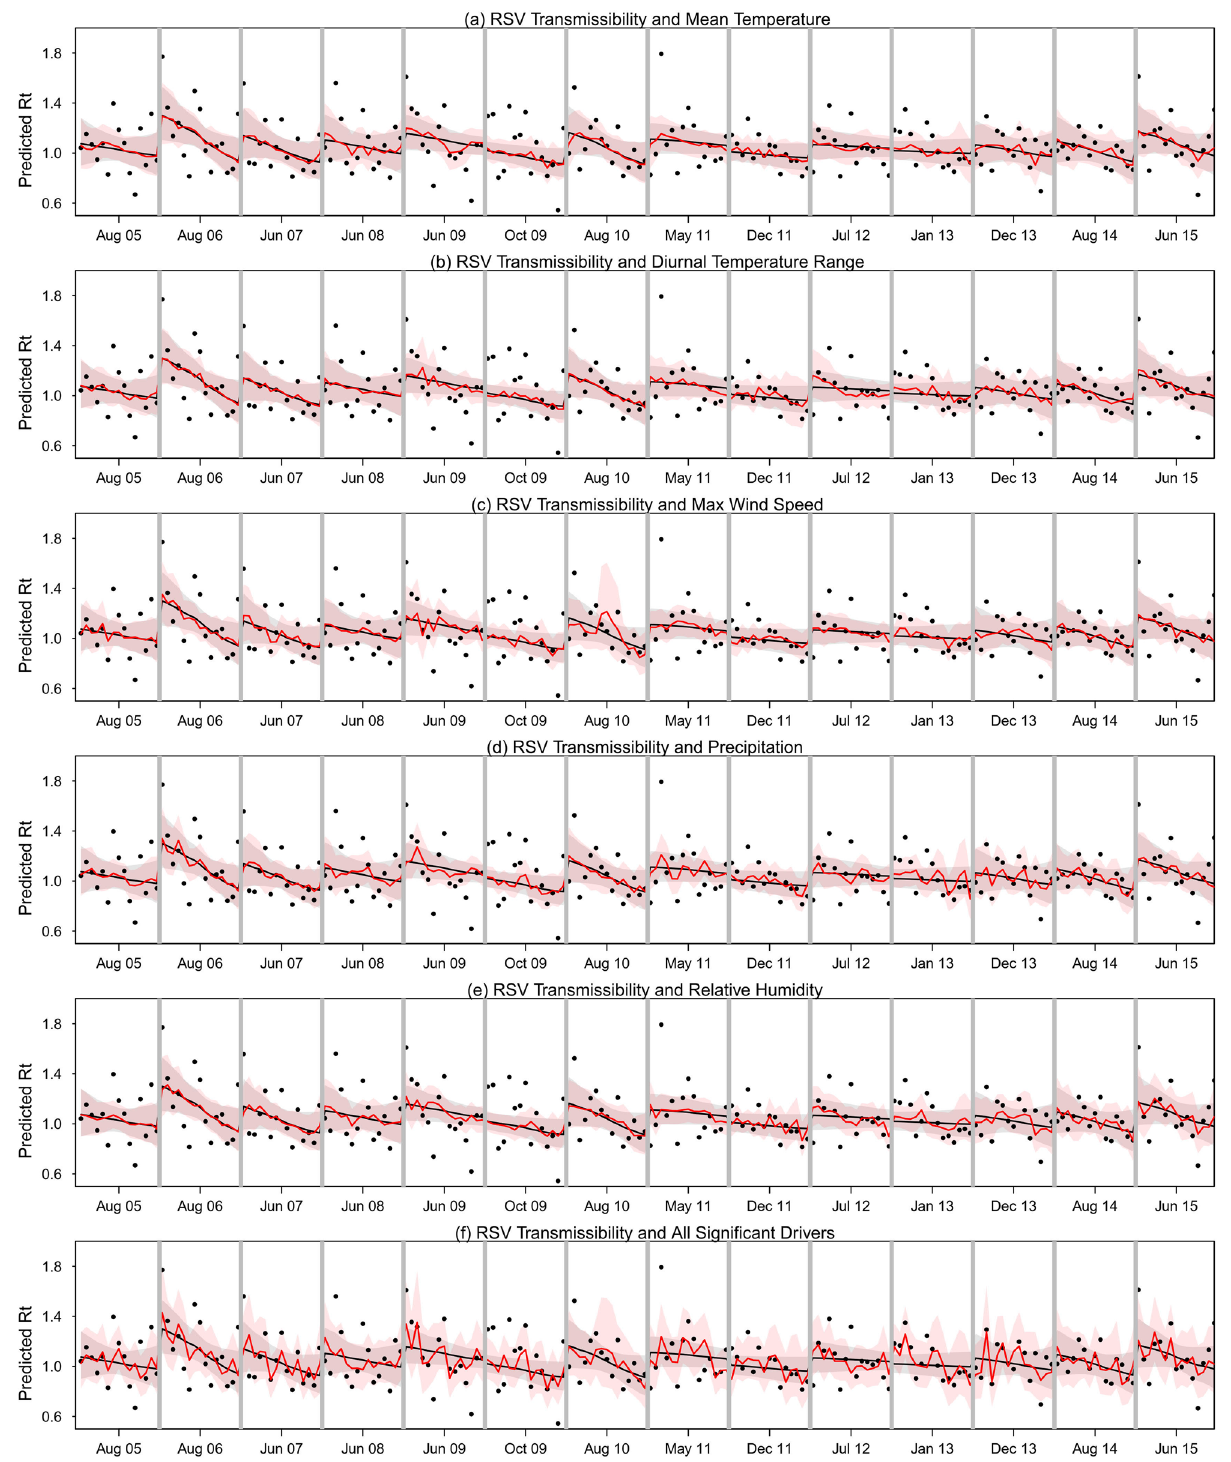
Figure 2. Effective reproduction numbers inferred from the RSV hospital admissions time series (black dots) and the predicted effective reproduction numbers from basic models with inclusion of depletion of susceptible and the inter-seasonal factors only (black lines) with 95% CI (light grey shaded area), and inclusion of meteorological drivers in addition to depletion of susceptible and the inter-seasonal factors (red lines) with 95% CI (light red shades). Total 11 epidemics (with 14 peaks) of RSV transmission in Singapore during 2005–2015. The difference between the black line and the red line illustrates the improvement in fitting due to inclusion of respective drivers. We used a maximum duration of 7 weeks to both side of peaks and a 5-days moving average window to smooth daily hospitalization data for distributed lag model (DLM) with lags of 0–14